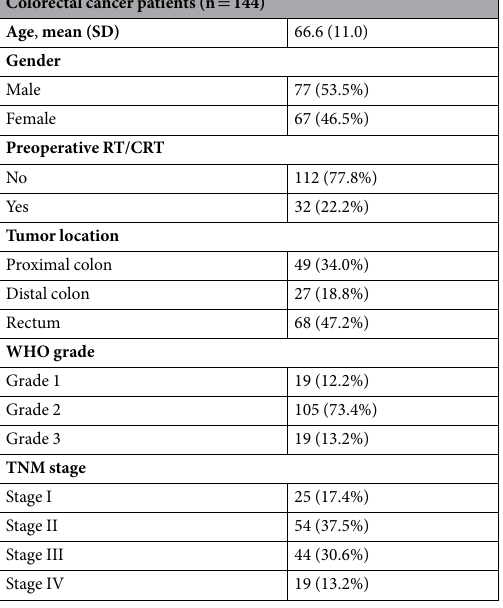
Table 1. Patient characteristics. Abbreviations: SD: standard deviation; RT/CRT: radiotherapy or